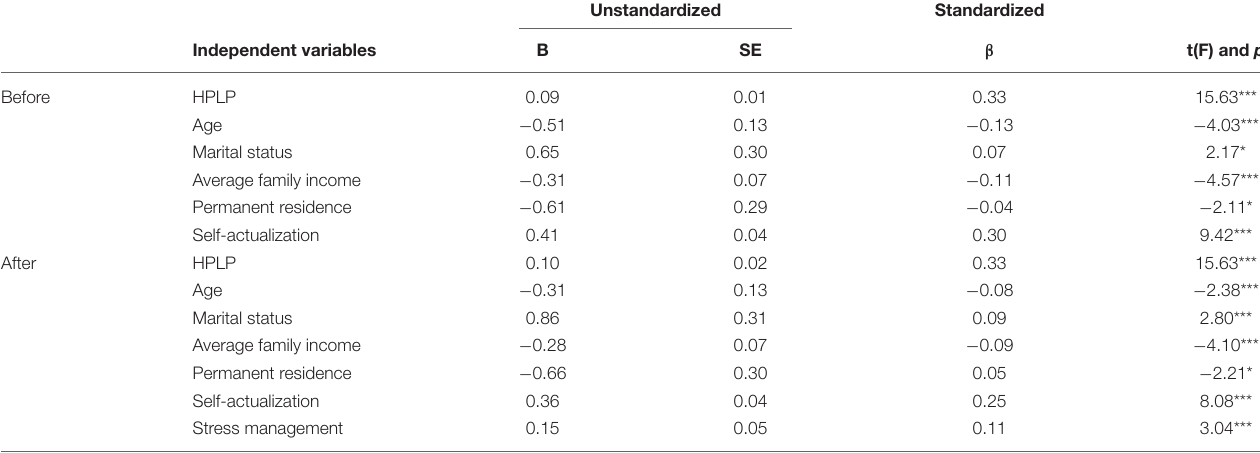
Unstandardized Standardized